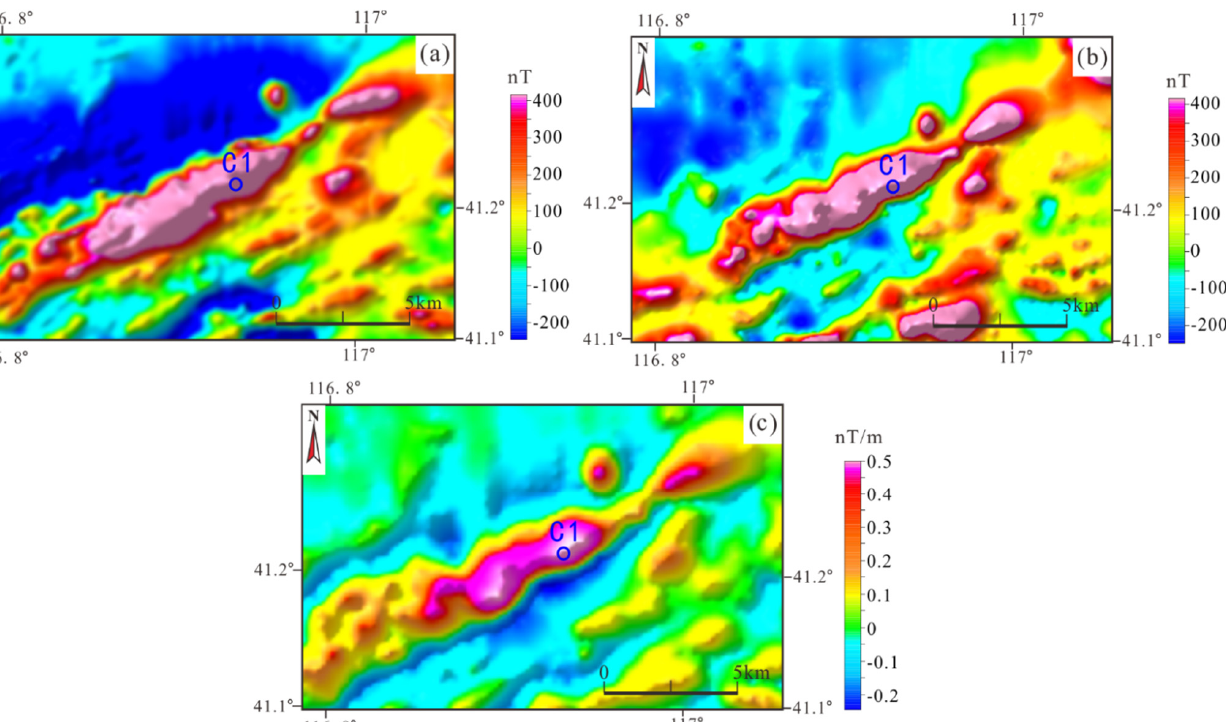
Figure 4. Aeromagnetic anomaly and its conversion of a sedimentary metamorphic magnetite in the study area: ( a ) Aeromagnetic data ∆ T, ( b ) reduction to the pole of aeromagnetic data ∆ T, ( c ) the first vertical derivative of reduction to the pole of aeromagnetic data ∆ T.